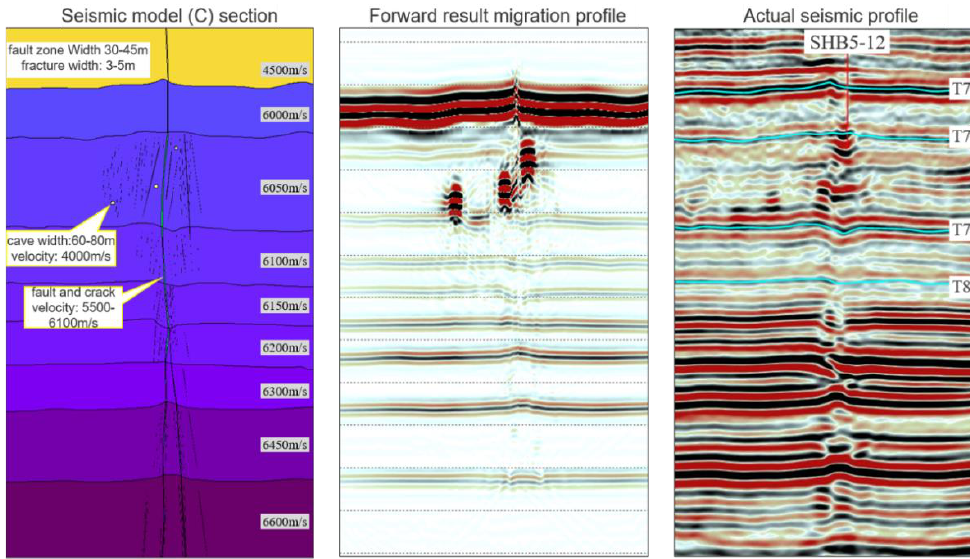
Figure 13. A comparison between migration results of forward model C and seismic profile of actual drilling.